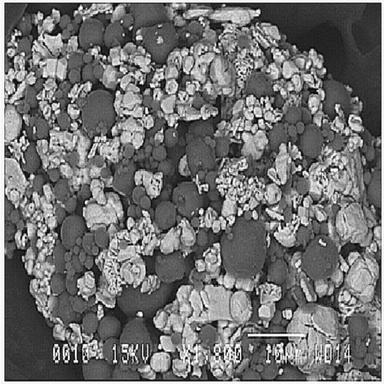
An example of Al-Mo atomized droplets being sprayed on filter paper. Note that the Inner tip size: 1.01 mm / Outer tip size: 1.52 mm, the feed rate of the suspension: 5.00 ml/min, the pressure of argon plasma gas: 50.00 PSI, and the carrier gas flow: 80.00 mm are the set of parameters employed to atomize the suspension and obtain the droplets.